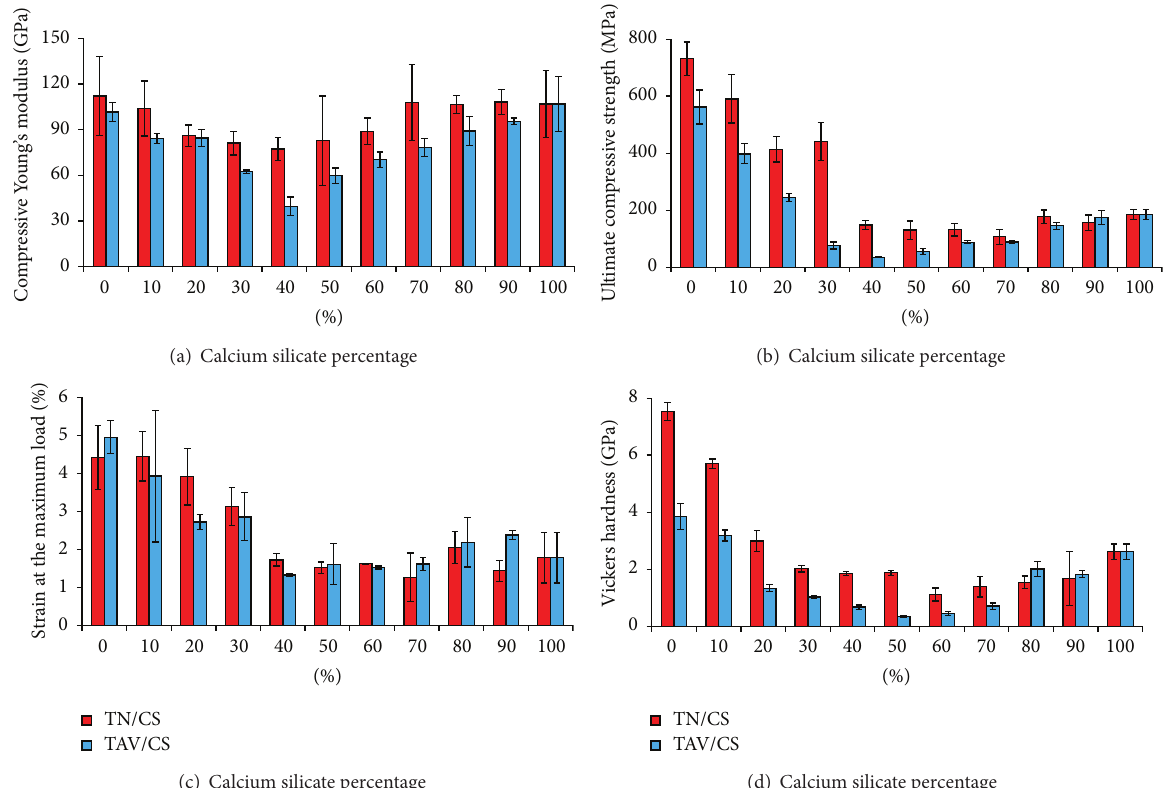
Figure 9: Mechanical properties of Ti-55Ni/CaSiO 3 (TN/CS) and Ti-6Al-4V/CaSiO 3 (TAV/CS); (a) compressive Young’s modulus; (b) ultimate compressive strength; (c) strain at maximum load; (d) Vickers hardness.